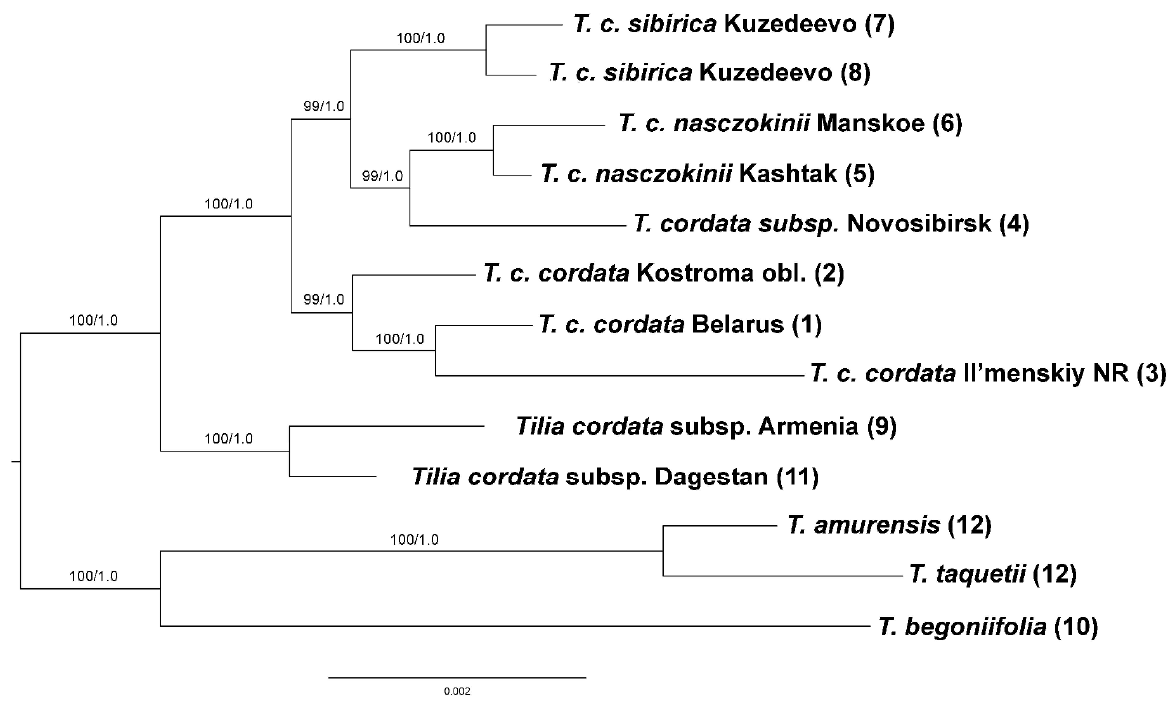
Figure 2. Phylogenetic tree of the studied specimens constructed using the ML method. Numbers in brackets after specimen names refer to location numbers (Figure 1, Table 1). Numbers at the branches indicate ML bootstrap support/Bayesian bootstrap support.